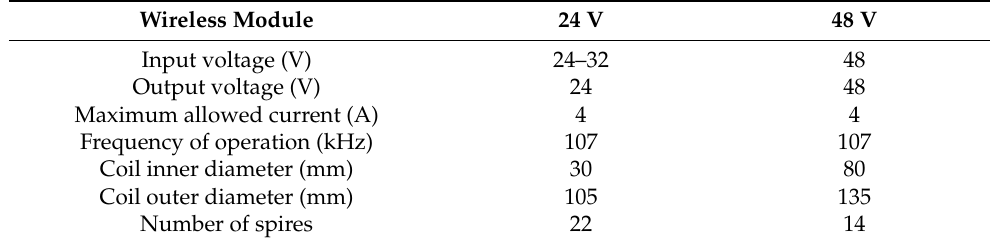
Table 1. Wireless module Taidacent™